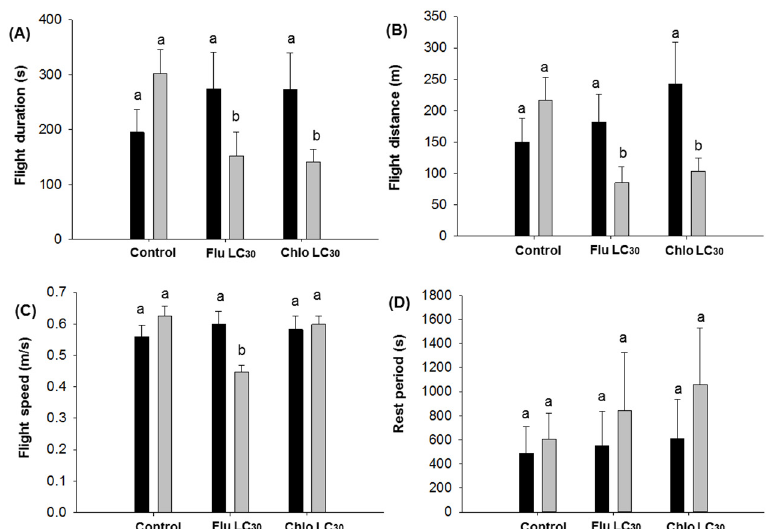
Figure 7. First flights of Chloridea virescens less than 30 min: ( A ) Flight duration, ( B ) flight distance, ( C ) flight speed, and ( D ) rest period. Black bars represent female and grey bars represent male moths. Di ff erent letters above the standard error bars indicate significant di ff erences based on Tukey–Kramer test ( p < 0.05).